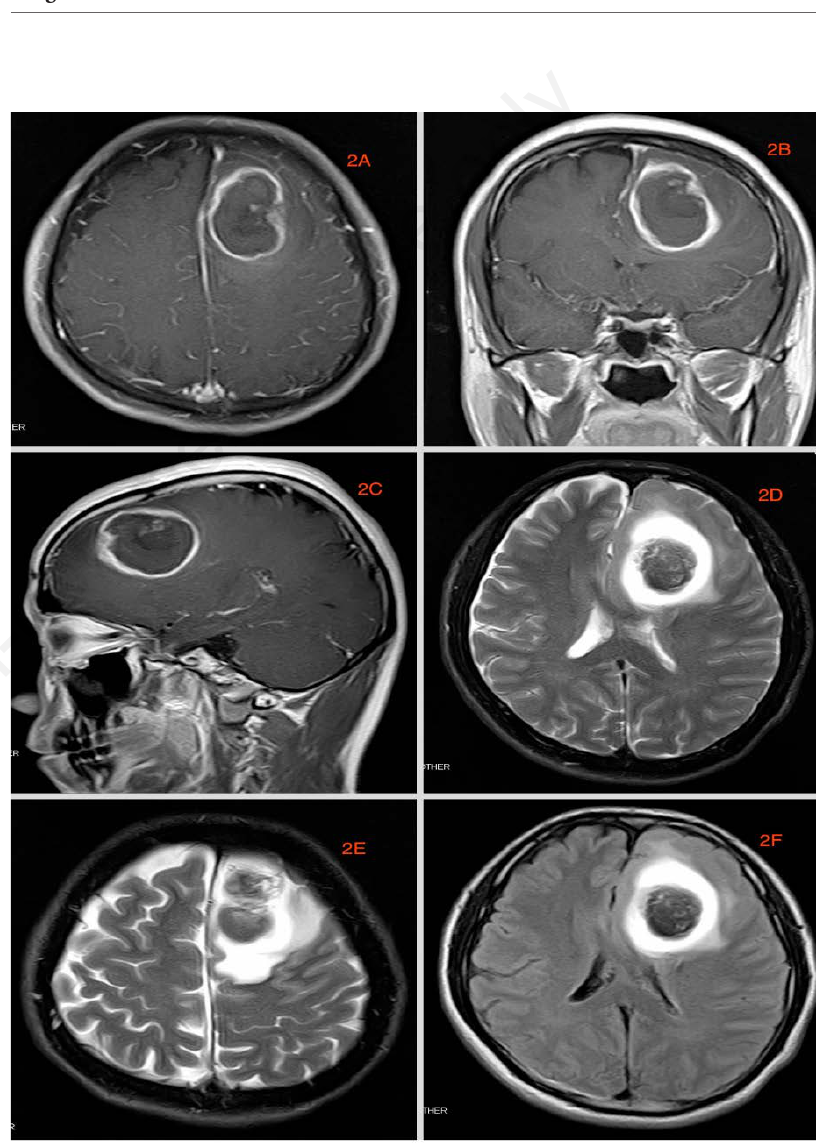
Figure 2. MRI image done at our facility. A-C) are axial, coronal and sagittal T1 image respectively. D,E) are axial T2 images while 2F is FLAIR. These images show ring like lesions that are consistent with Glioblastoma. The delay window of the evolution process was up to 14